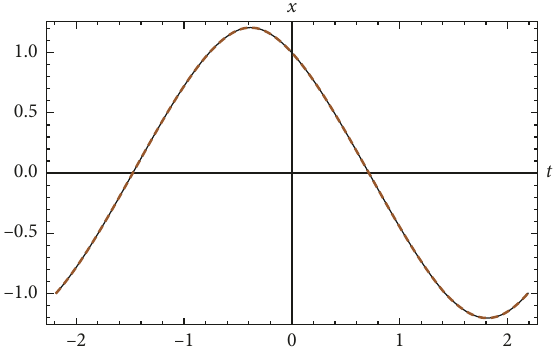
Figure 3: Comparison between the exact solution and the approximate analytical solution for Example 3.